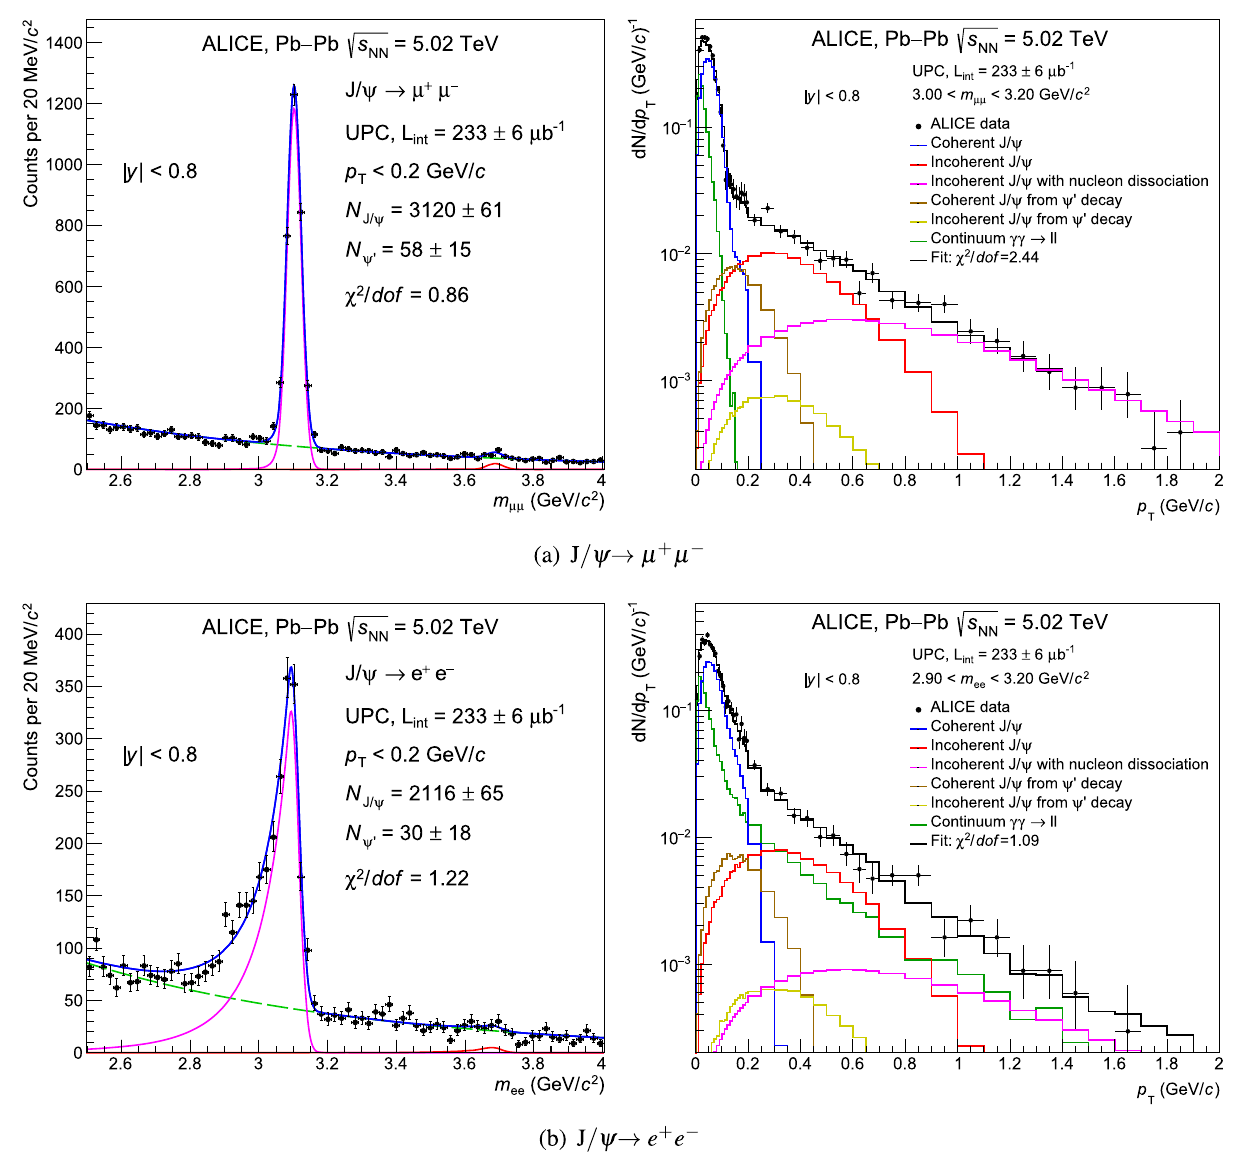
Fig. 1 Left:Invariantmassdistributionof l + l − pairs.Thedashedgreen linecorrespondstothebackground.Thesolidmagentaandredlinescor- respond to Crystal Ball functions representing the J /ψ and ψ (cid:2) signal, respectively. The solid blue line corresponds to the sum of background